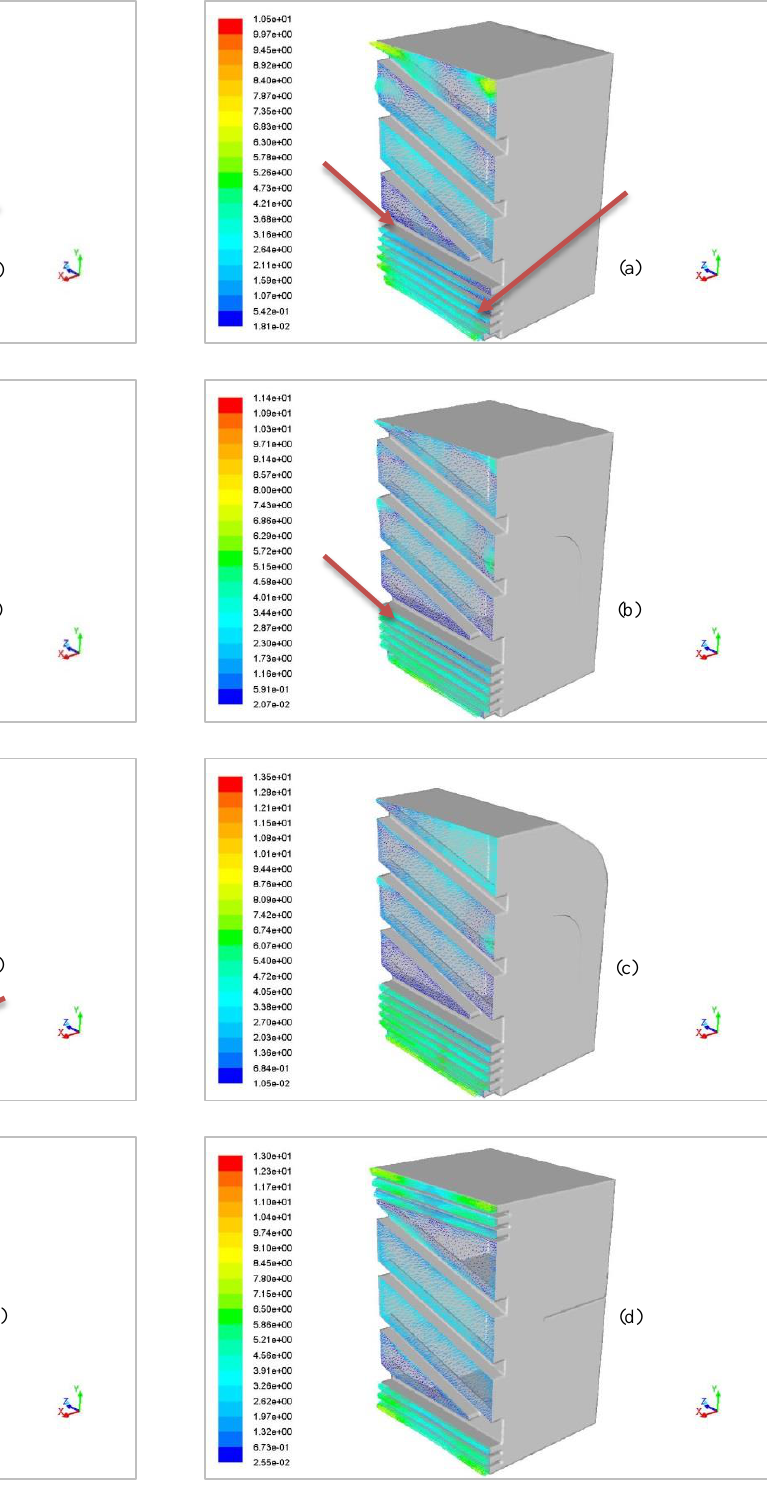
Fig.11. Velocity vector fields [m/s] (a) without guide vanes, (b) with one Fig. 12. Inlet and outlet velocity vector fields [m/s] (a) without guide stream guide vane, (c) with two stream guide vanes, (d) with stream sepa- vanes, (b) with one stream guide vane, (c) with two stream guide vanes, ration. The dead-zones and adverse flow events are indicated by red ar- (d) with stream separation. The dead-zones and adverse flow events are rows indicated by red